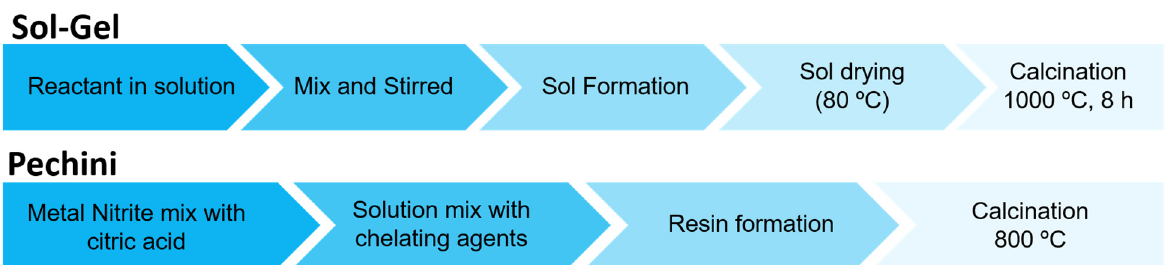
Figure 3. Summary of steps for each perovskite synthesis method discussed.